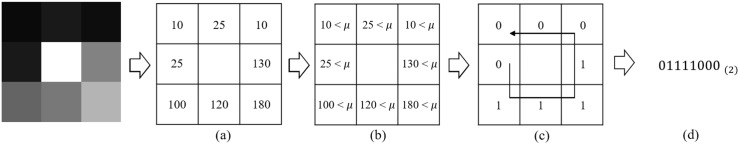
Example of the Byte-MCT code generation.